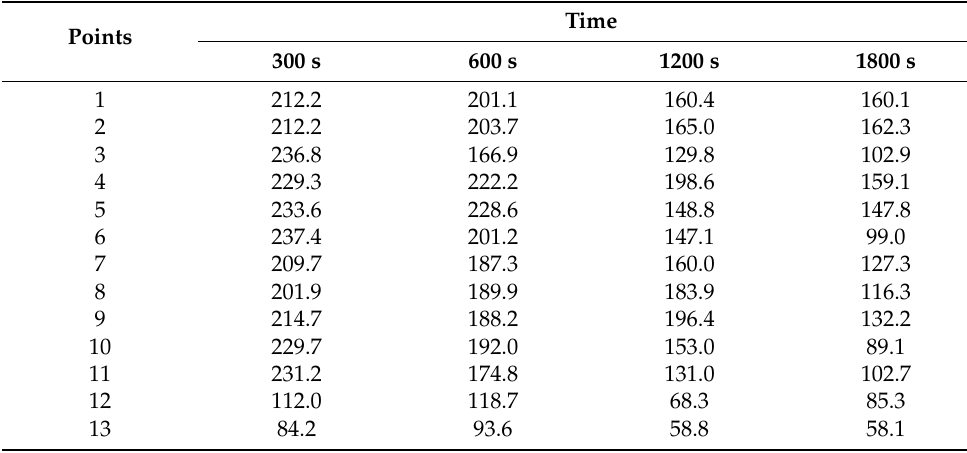
Figure A8. The simulation results of case 9 at the time of ( a ) 300 s; ( b ) 600 s; ( c ) 1200 s; ( d ) 1800 s. Table A8. Quantitative results of case